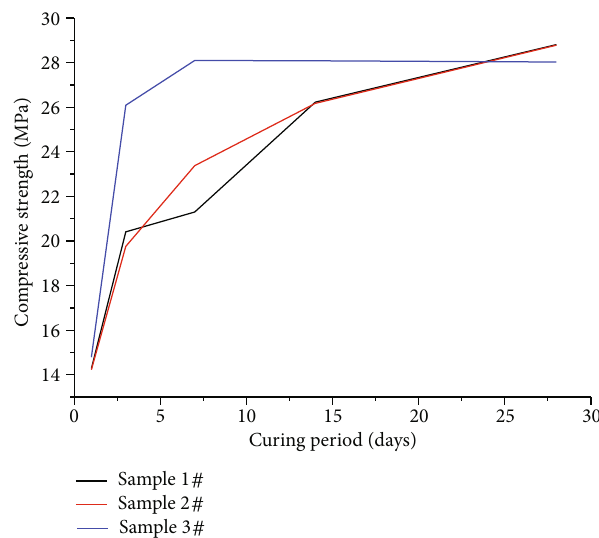
Figure 10: Compressive-strength test 3. Note: sample 1#: FLA A added (FLA A 0.5%BWOC, SXY 0.75%BWOC); sample 2#: FLA A added (FLA A 0.7%BWOC, SXY 0.75%BWOC); sample 3#: PVAGB/FLA A added (PVAGB 0.20%BWOC, FLA A 0.5%BWOC, and SXY 0.75%BWOC).